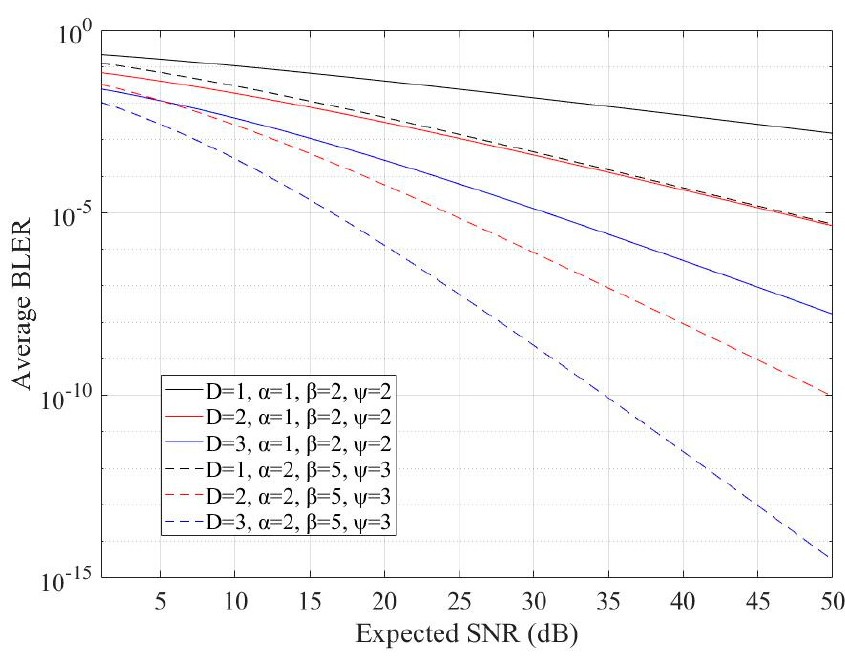
Figure 1. ABLER performance versus the expected SNR for M = 3, N = 5, and 4-PPM scheme.